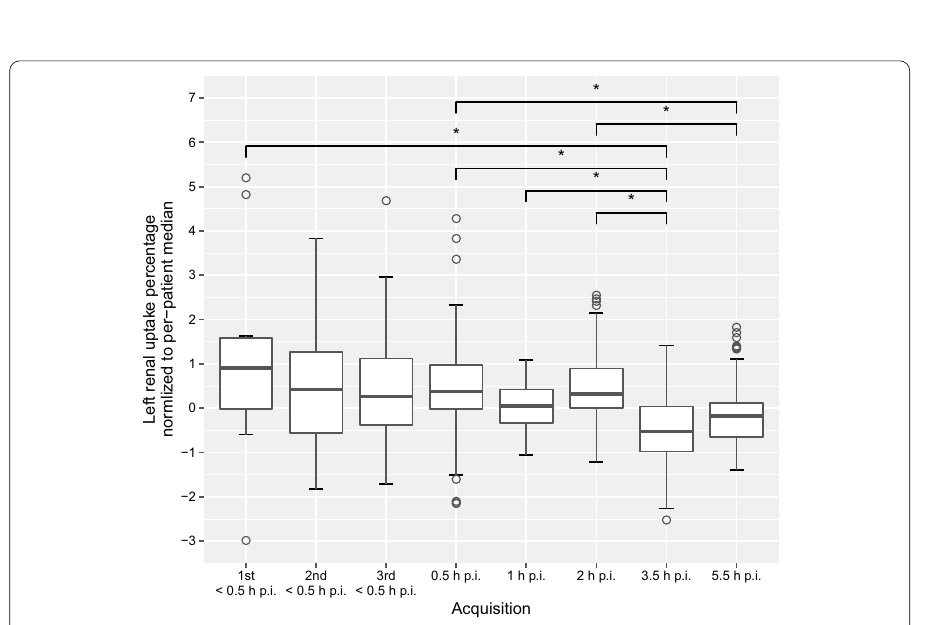
Fig. 5 Left renal uptake percentages (LRU%) normalized to per-patient median to allow comparison between acquisitions for all patients. The central line in each box represents the median. The lower and upper bounds of each box represent the 25 th and 75 th percentiles, respectively. Bars represent 1.5 times the interquartile ranges, with circles representing outliers outside these. The 3.5-h p.i. acquisition had significantly lower LRU% than the 1st acquisition and the 0.5 h, 1–h, and 2-h p.i. acquisitions. The 5.5-h acquisition had significantly lower LRU% than the 0.5- h and 2-h p.i. acquisitions. No other significant differences were found. * p < 0.005 using Dunn’s test with Bonferroni correction for multiple comparisons. p.i.: